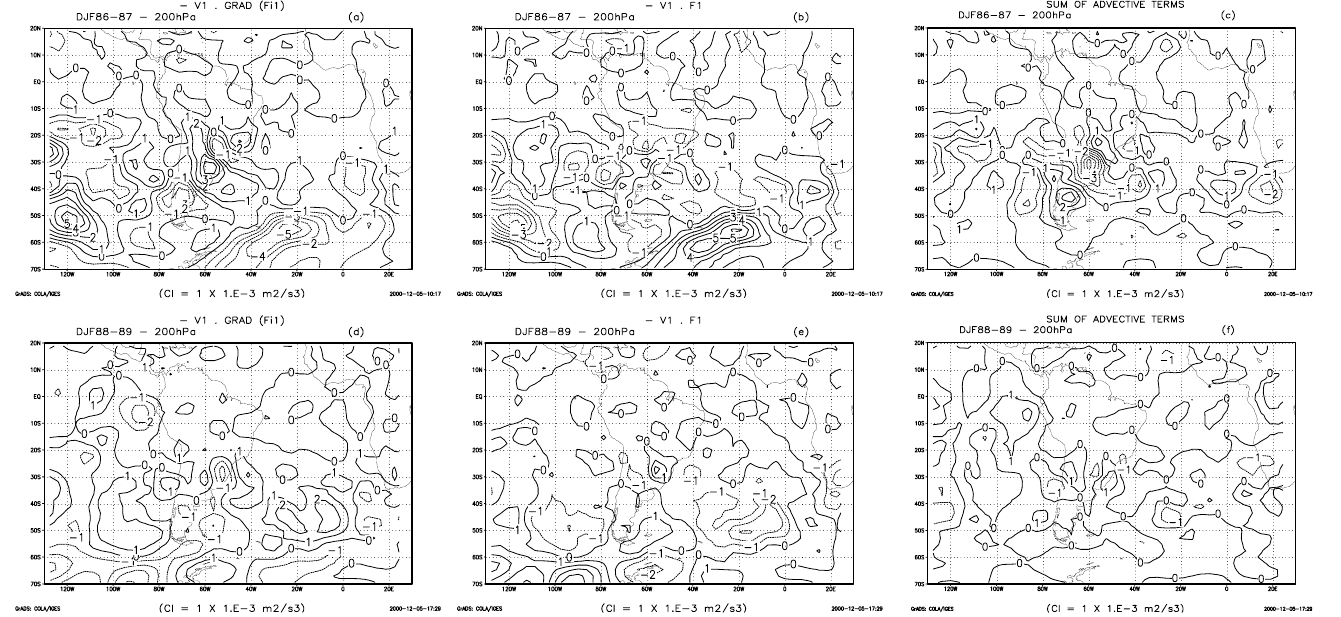
Fig. 8. Episodal average of the spatial distribution of (a), (d) h− V 1 · ∇ 8 1 i , (b), (e) h V 1 · F 1 i and (c), (f) the sum of the four advective terms on the right-hand side of the kinetic energy equation (7) denoted as SAT, to summers of NDJF of 1986–1987 and 1988–1989,